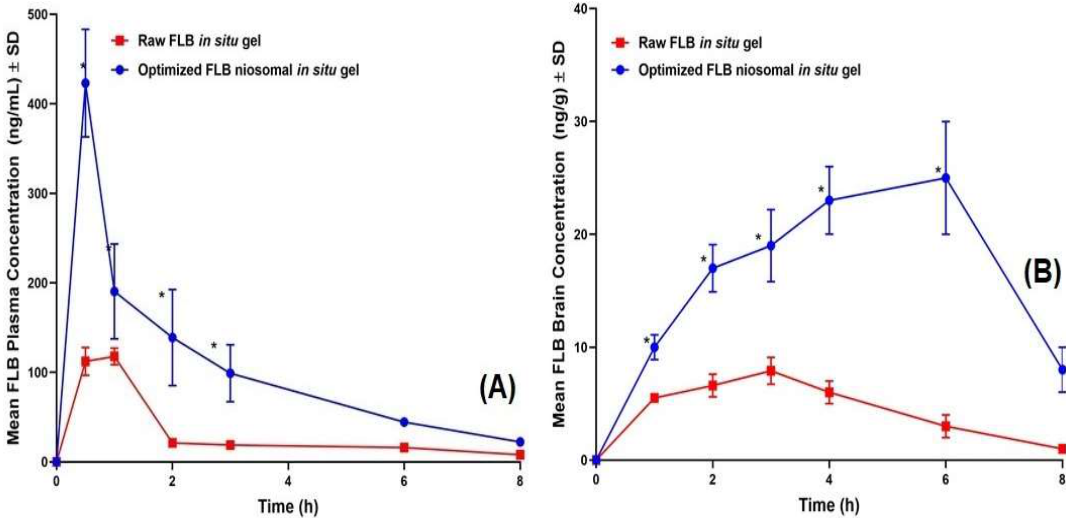
Figure 7. Mean ( A ) plasma concentrations and ( B ) brain concentrations versus time of FLB in rats after nasal administration of FLB niosomal in situ gel compared to control raw FLB in situ gel at a dose of 10 mg / kg. (Results presented as mean ± SD, n = 6). * Significant at P < 0.05, Sidak’s multiple comparisons test compared to raw FLB gel. Table 6. In vivo pharmacokinetic parameters following intra-nasal administration of optimized FLB niosomal in situ gel compared to raw FLB in situ gel.